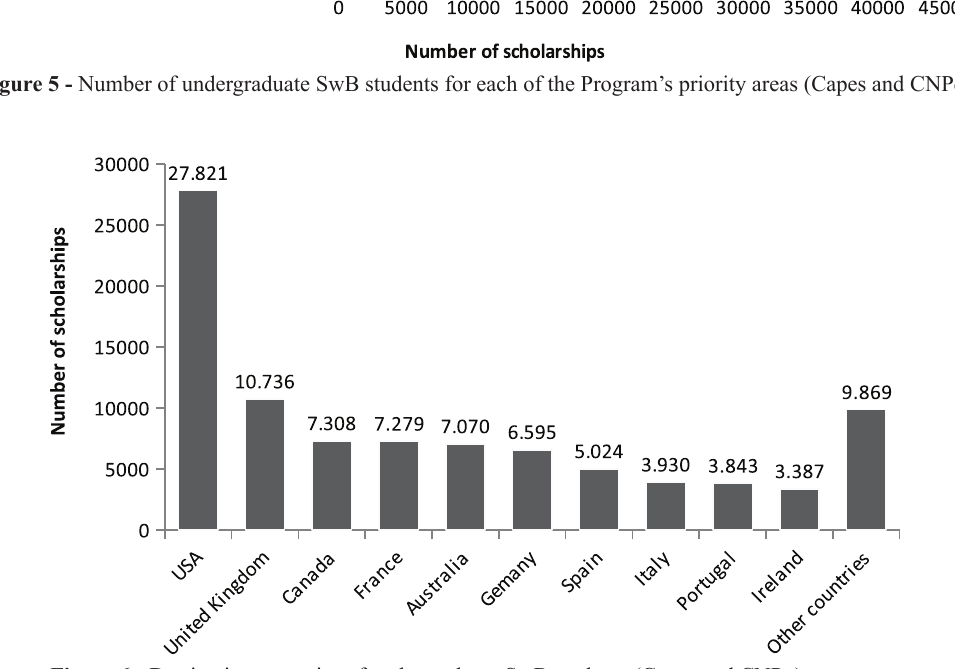
Figure 6 - Destination countries of undergraduate SwB students (Capes and